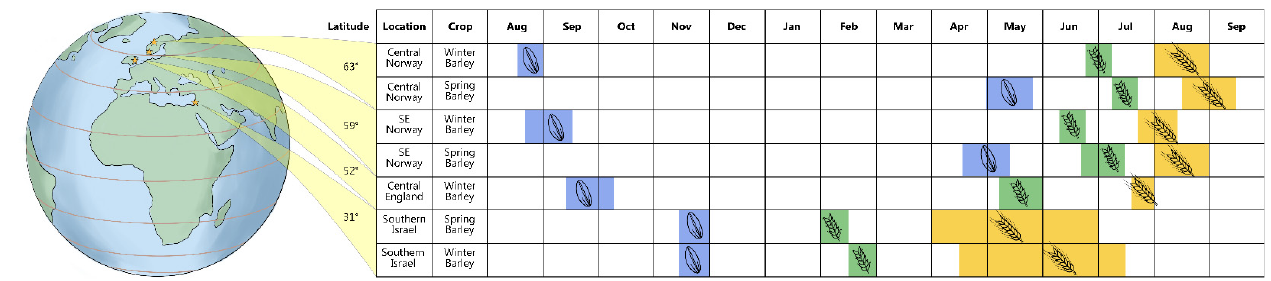
Figure 2. Spring and winter barley phenology at different latitudes: sowing, flowering and post- maturation harvesting. Under modern cultivation in high latitudes, winter habit cereal varieties are sown and germinated before the frost of winter, completing their lifecycle in spring and summer; spring habit varieties are sown after the frost of winter and rapidly complete their lifecycle slightly later than winter varieties. In lower latitudes, where winter frosts pose little concern, the offset between winter and spring varieties is minimal; indeed, spring varieties are often preferred for their shorter lifecycle. In ancient cultivation, spring habit varieties evolved together with the spread of barley (and wheat) to higher latitudes and altitudes. Approximate timings listed here represent a typical year in each locale but are often offset by 2–3 weeks depending on the timing of rainfall.